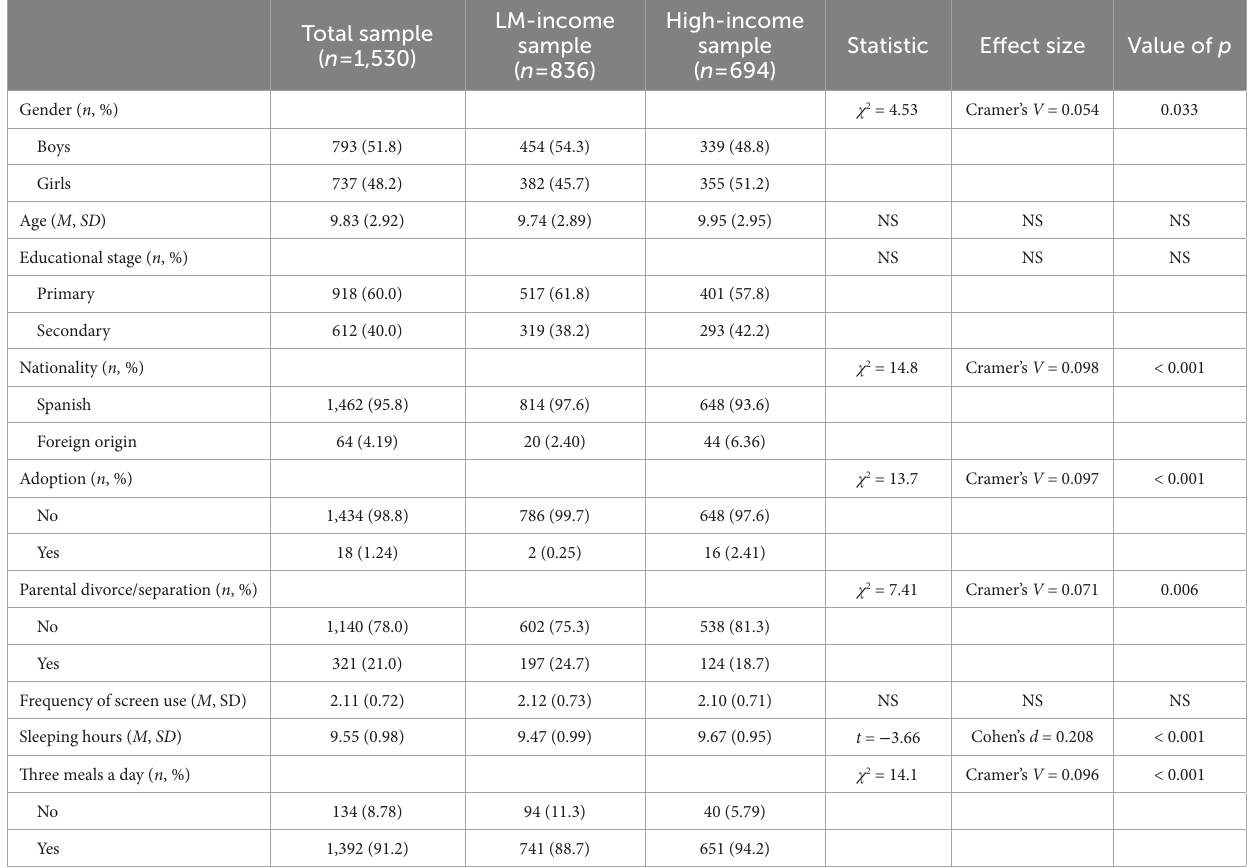
TABLE 1 Demographic characteristics of the study